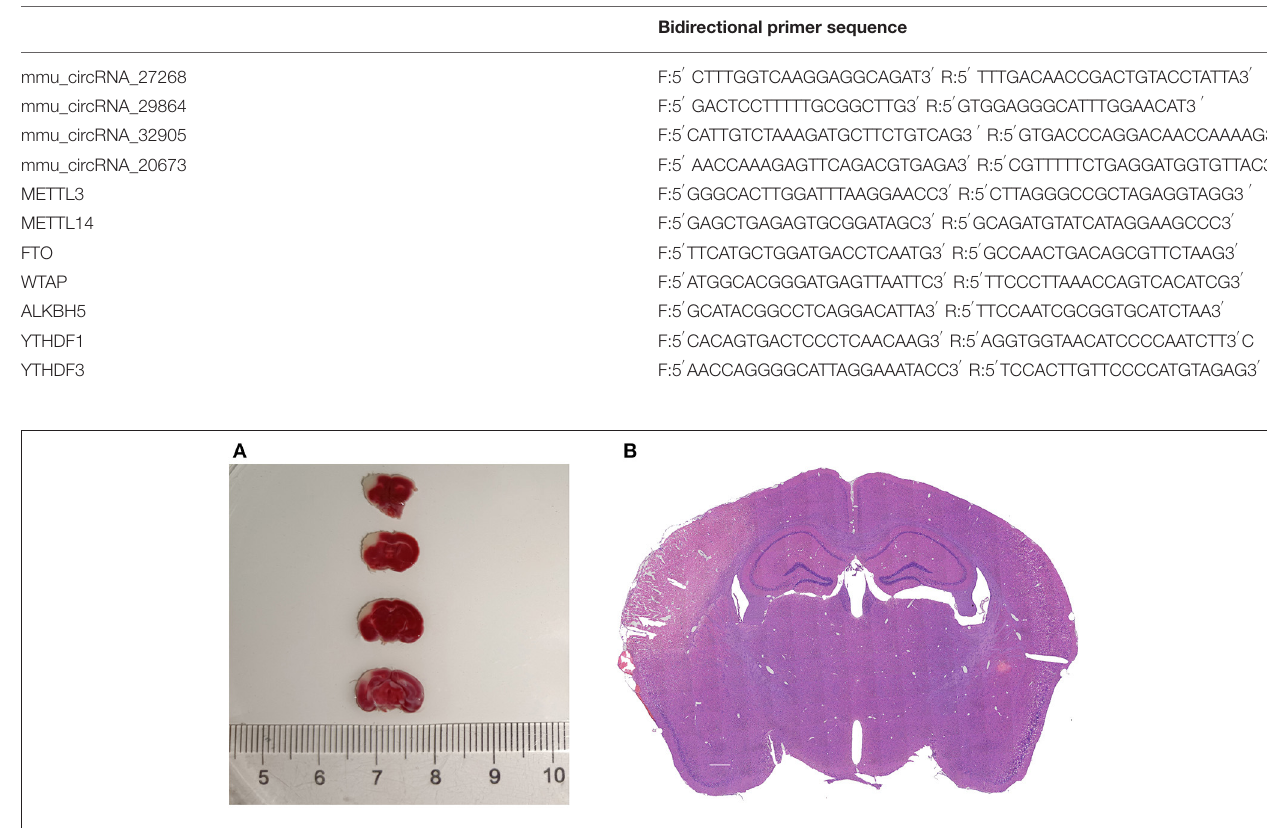
TABLE 1 | The primer sequence of the four differentially m 6 A-modified circRNAs and m 6 A-related enzymes.